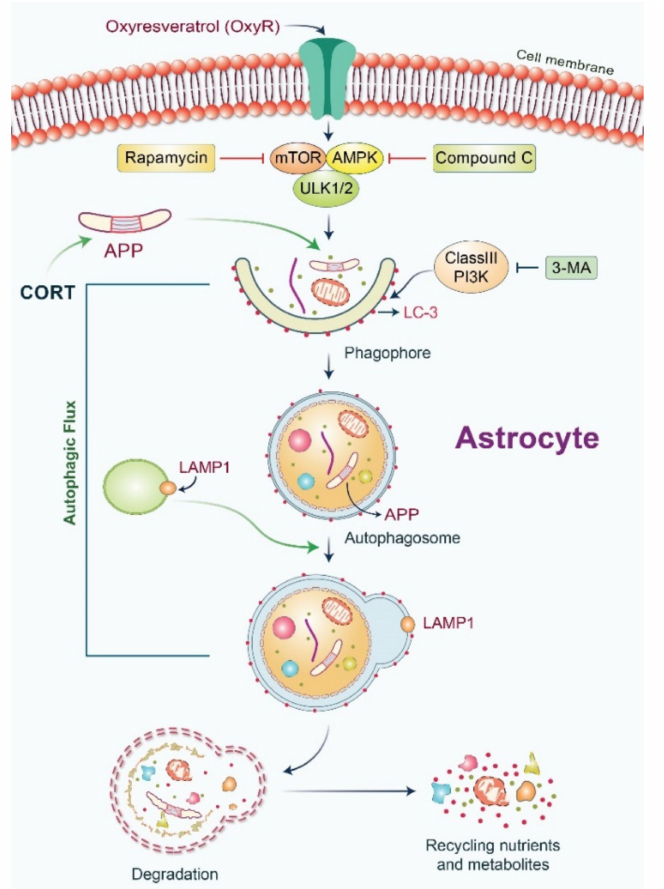
Figure 7. Model of OxyR-mediated APP reduction and autophagy induction in cortical astro- cytes. OxyR initiates autophagy via stimulation of the AMPK/ULK1/mTOR pathway to activate phagophore formation and subsequently autophagosome maturation. CORT-initiated APP expres- sion is followed by APP engulfment by autophagosomes. The lysosomal protein LAMP1 supports the binding of lysosomes with autophagosomes. Finally, APP is degraded by the autophagosome- lysosomal pathway, and the released nutrients and metabolites are recycled. AMPK, AMP-activated protein kinase; mTOR, mammalian target of rapamycin; ULK1, Unc-51-like autophagy activating kinase 1; APP, amyloid precursor protein; ClassIII PI3K, class III PI3-kinase; 3-MA, 3-methyladenine; LAMP1, lysosomal-associated membrane protein